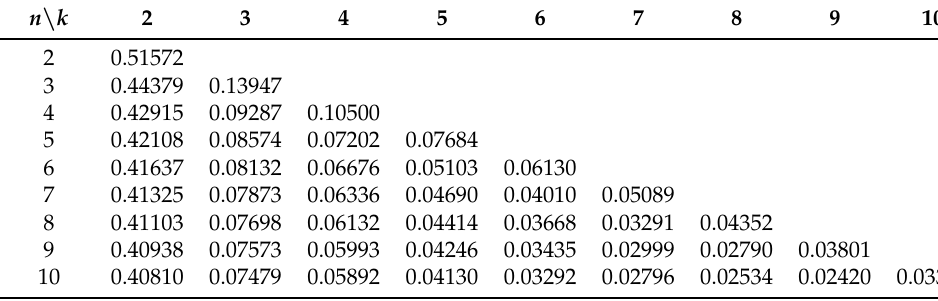
Table 4. Coefficients Γ k n for H = 0.8.